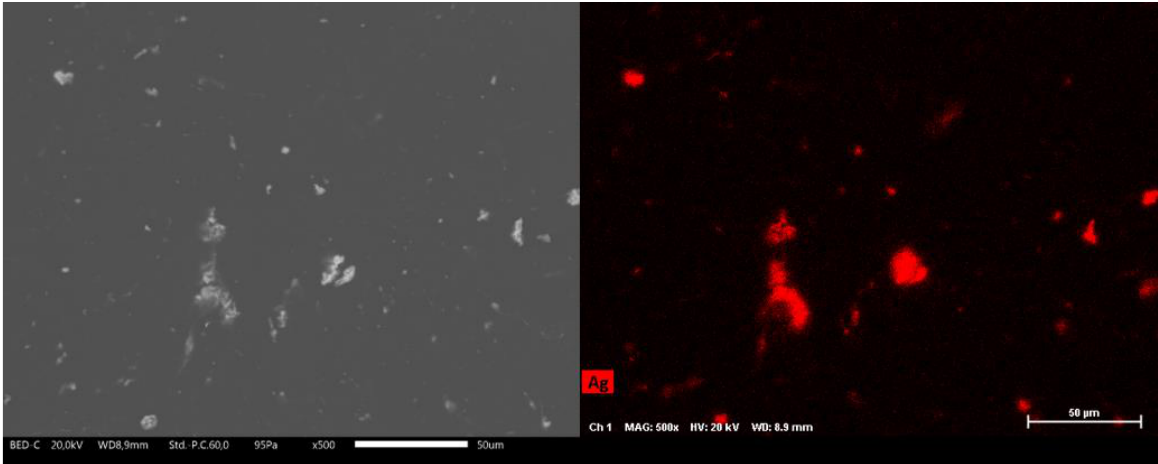
Figure 5. SEM micrograph of the surface of sample A1, with relative EDXS map of Ag element.